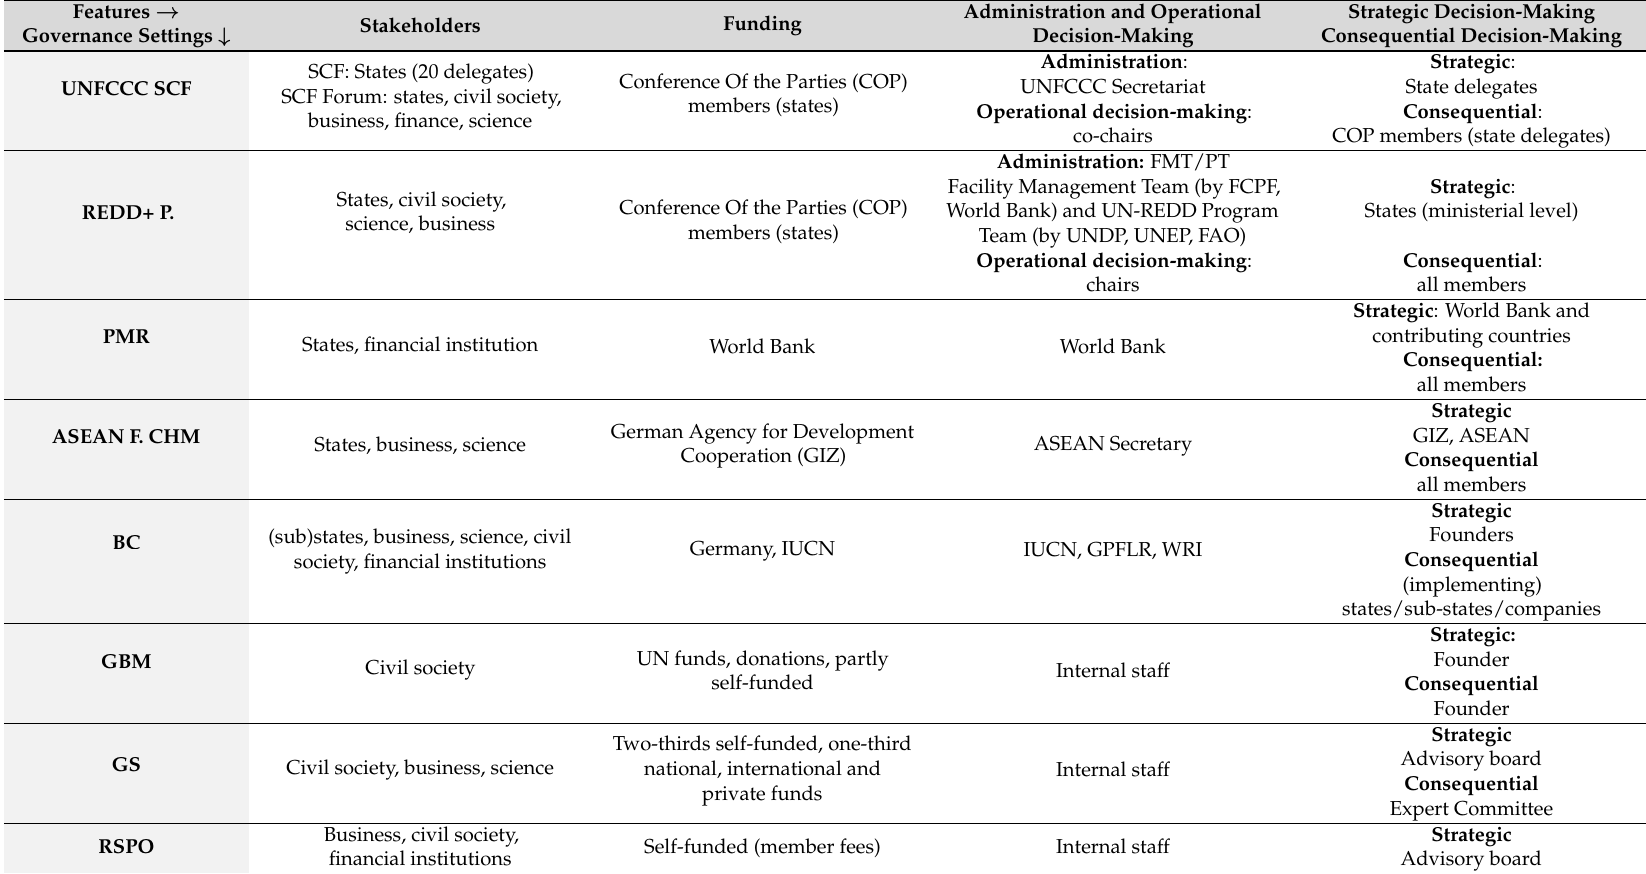
Table 2. Features of governance